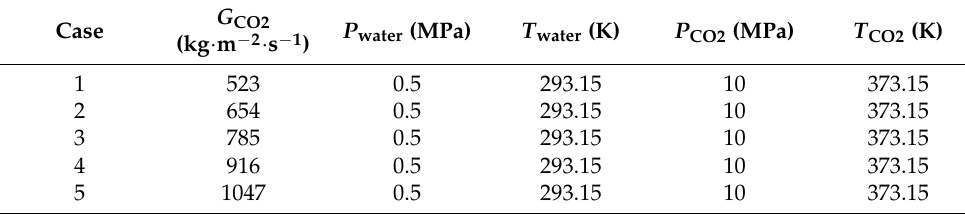
Figure 11. Variation in the average heat transfer coefficient of CO 2 at different cooling